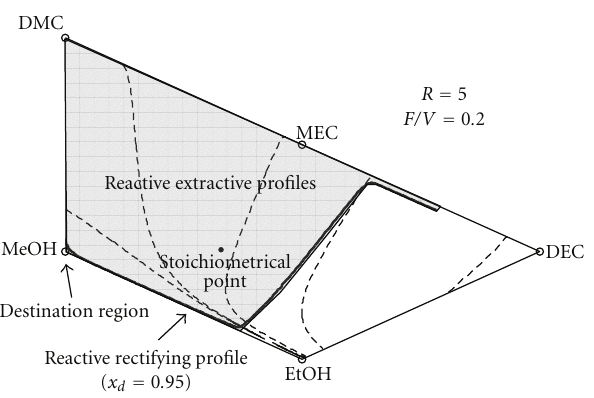
Figure 7: Reactive extractive profiles at S = 10 and at F w /L = 0 . 3.